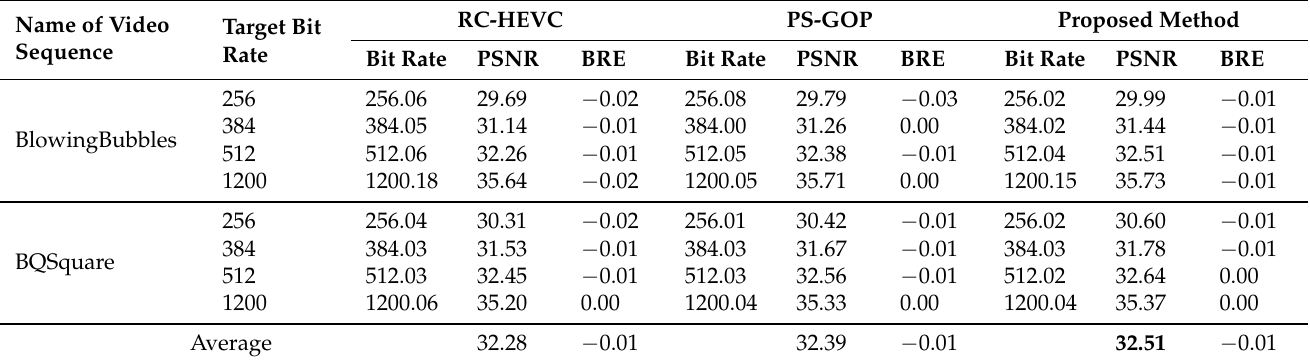
Table 2. The Performance of PSNR and BRE of Video Sequence with Resolution of 416 × 240.